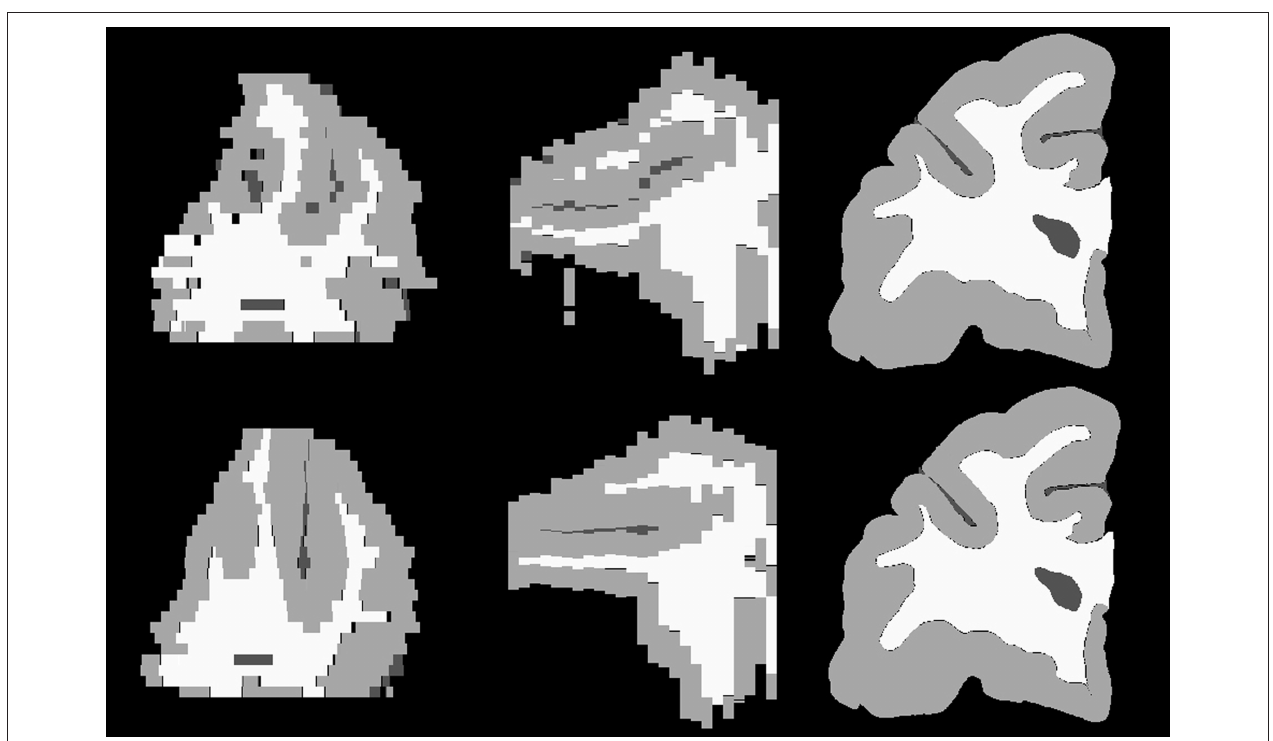
FIguRe 3 | Axial (left), sagittal (middle), and coronal (right) slices of reconstructed 3D histology image without (top) and with (bottom) 2D rigid